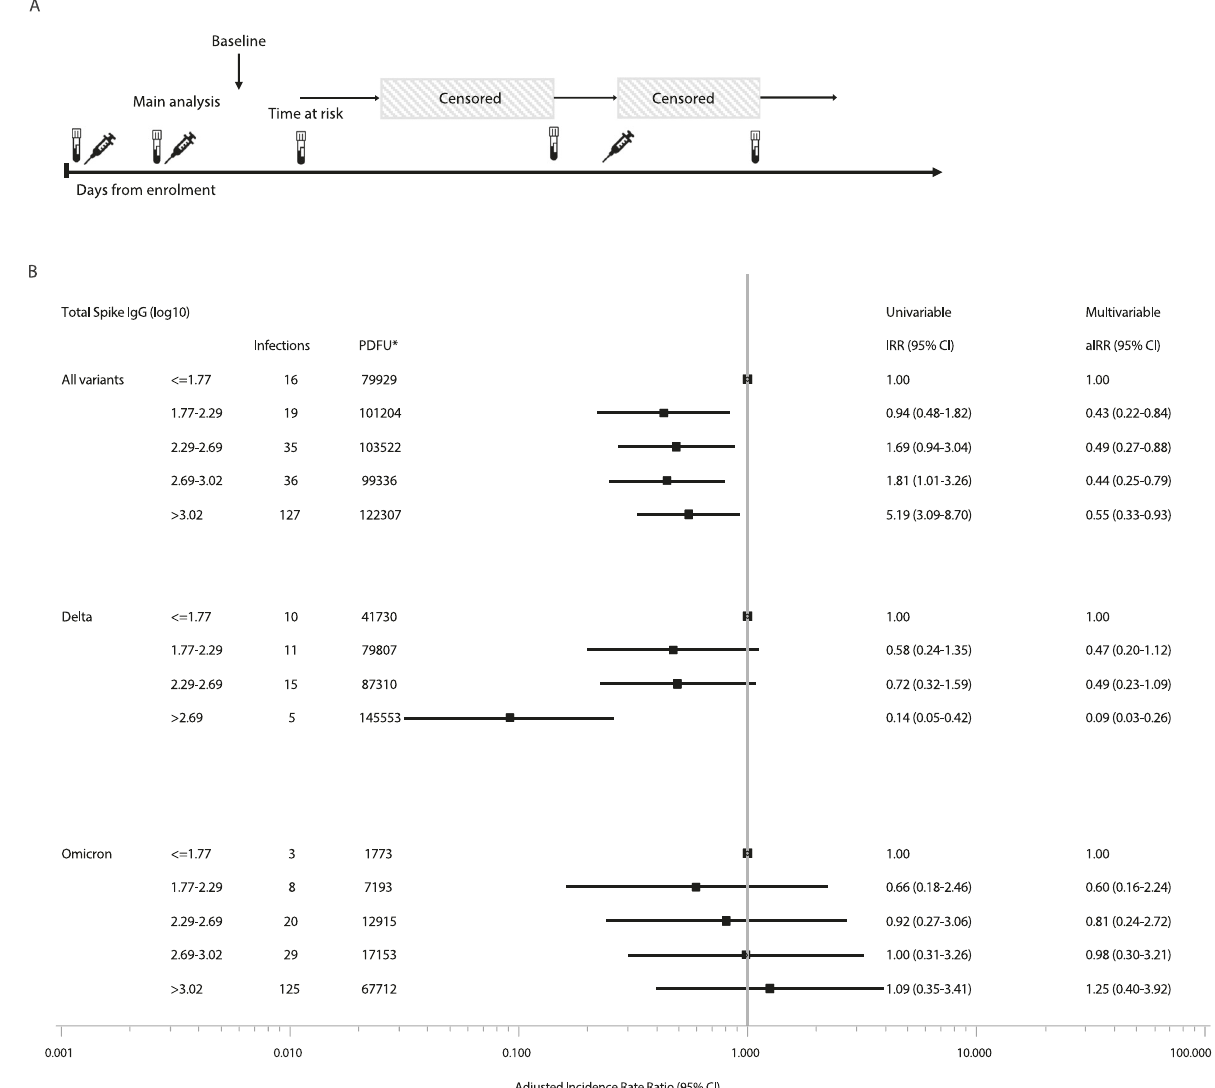
Fig. 2 | Sensitivity analysis adjusted and unadjusted incidence rate ratios for breakthroughinfection.A Schematicoverviewoftheanalysisdesign.Thesyringe icon represents vaccinations, the blood sample icon represents blood draws, and the shaded areas represents the censored time periods. The analysis includes the fi rstthirtydays followingeach study visitblooddraw. B Forestplotof the adjusted incidence rate ratios (aIRR) for breakthrough infections Incidence rate ratios (IRR) and adjusted incidence rate ratios (aIRR) for breakthrough infections calculated using a Poisson regression analysis for each quintile of SARS-CoV-2 anti-spike IgG log 10 BAU, strati fi ed by viral variant. Multivariable modelswere adjusted for age at